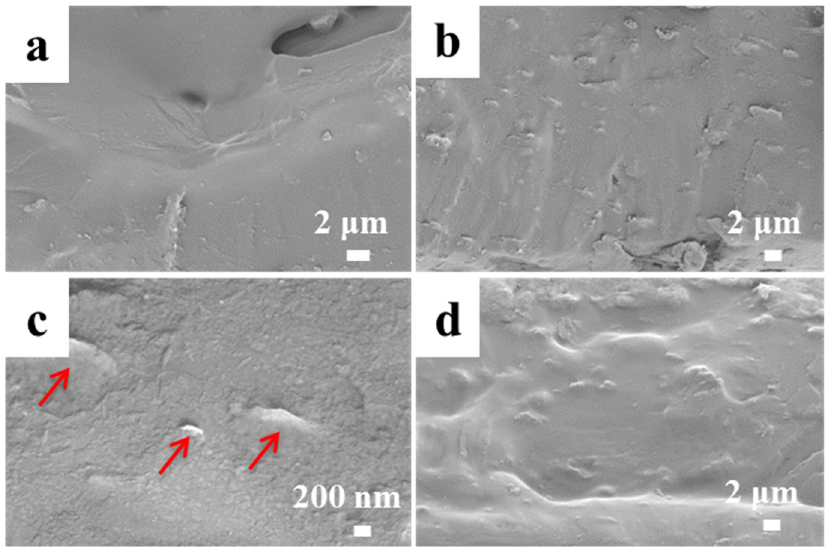
Figure 9. SEM images of the fracture surface for PVA and LDHs@TA-Ti/PVA nanocomposites (( a ), PVA; ( b , c ), LATP-1%; ( d ), LATP-5%).